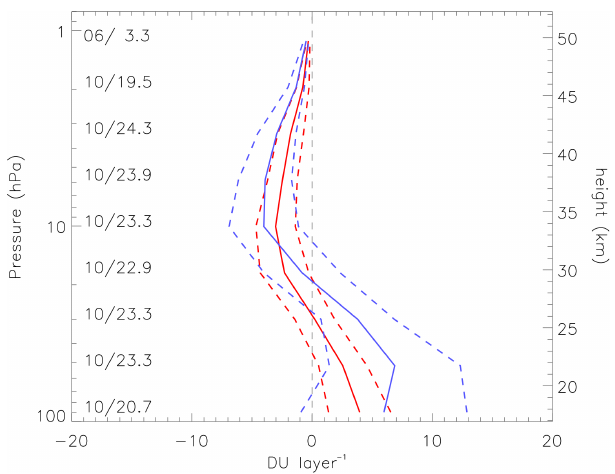
Fig. 16b. The mean of the absolute differences for collocations that occurred outside of the vortex boundary. The retrieval is plotted in blue and the a priori in red. The solid line is the mean, and the dashed lines are the ± 1 standard deviations. The first number in the column on the left side is the number of collocations between GOME-2 and the lidar and the second number is the mean number of lidar layers averaged for that layer during interpolation.